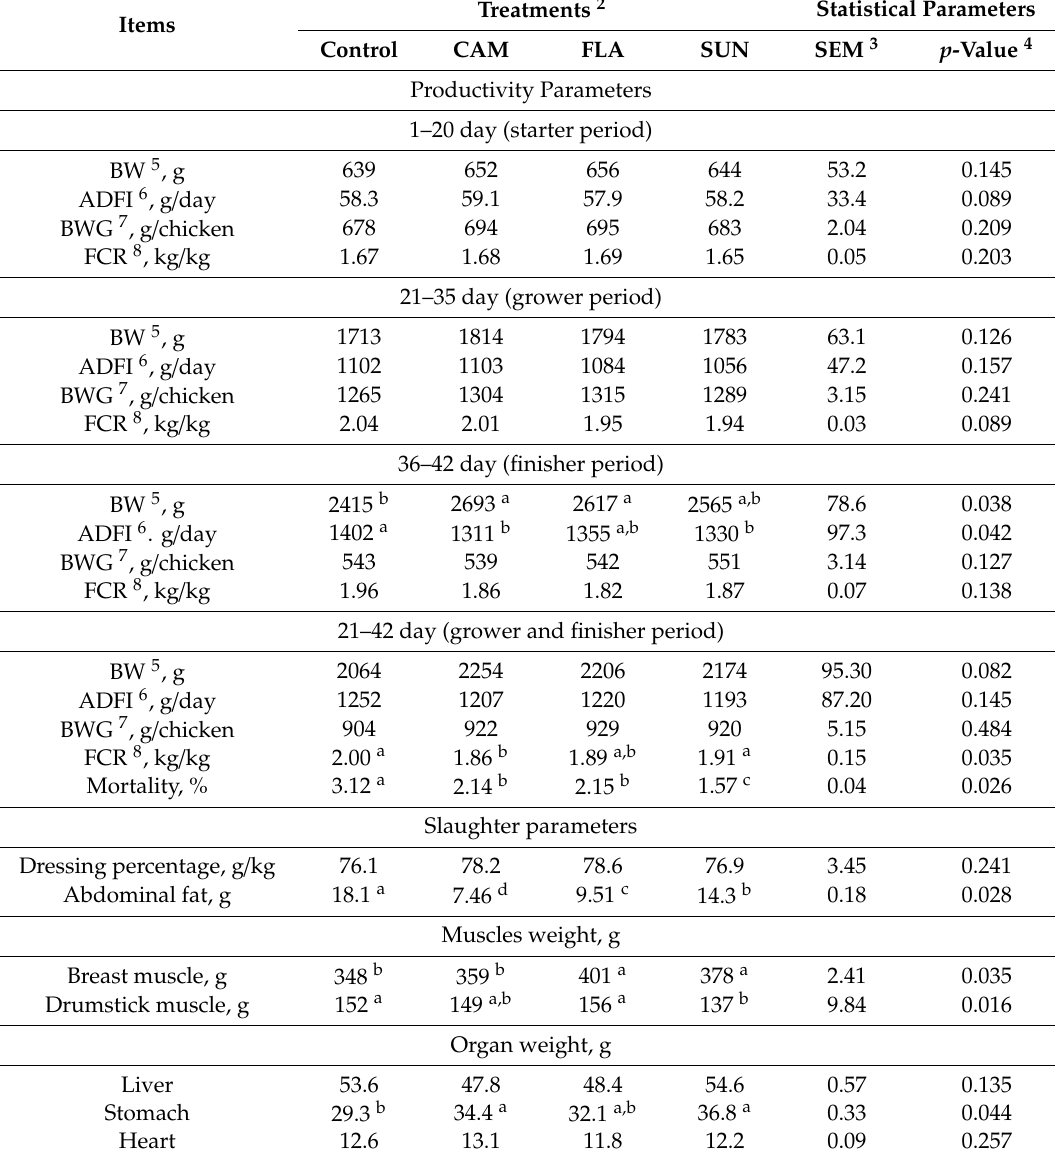
1 Data represent the mean of 5 cages (10 broiler chicken / cage) per treatment; 2 Control—diet without oilseeds; CAM—diet with 15% camelina seeds, FLA—with 15% flax seeds; SUN—diet with 15% sunflower seeds; 3